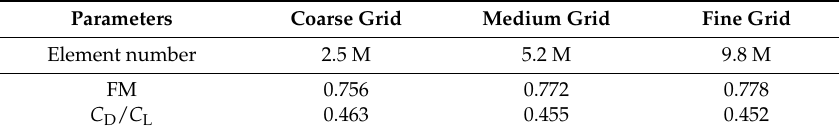
Table 1. Grid sensitivity analysis in hover and transition